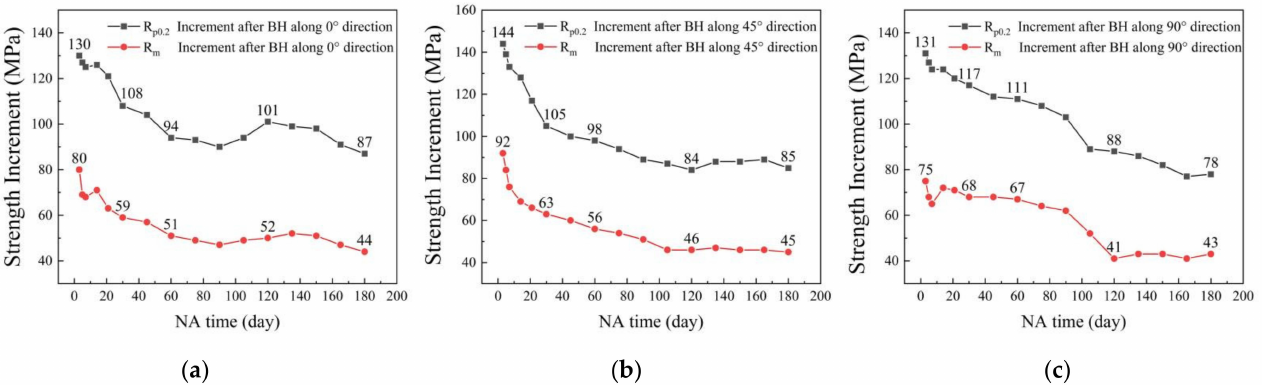
Figure 13. The change curves of R p0.2 increment and R m increment after bake hardening along 0 ◦ ( a ), 45 ◦ ( b ), and 90 ◦ ( c ) directions.